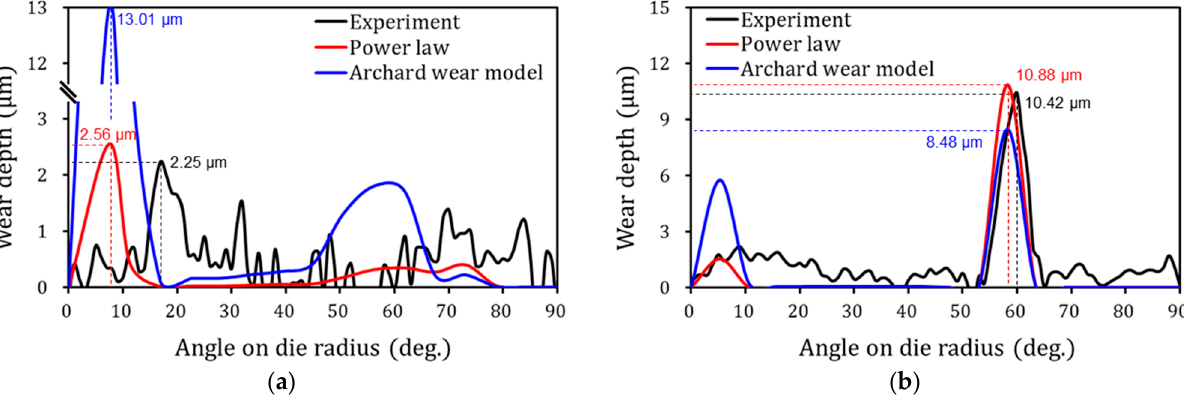
Figure 18. Comparison of wear depth profiles obtained by experiment and prediction: ( a ) conventional die and ( b ) modi- fied die.